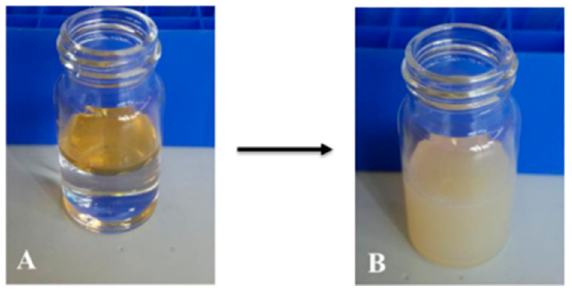
Figure 1. ( A ) Biphasic system formed by aqueous solution of NaOl (bottom) and CeO 2 _OL_250 NPs organic solution (top) before sonication and ( B ) final dispersion of functionalized NPs. Table 2. Summary of the different samples of cerium oxide nanoparticles synthesized with oleylamine at 250 °C (CeO 2 _OL_250 NPs) and functionalized with a constant amount of sodium oleate (NaOl). Molar Ratio NPs:(NaOl × 10 − 6 )